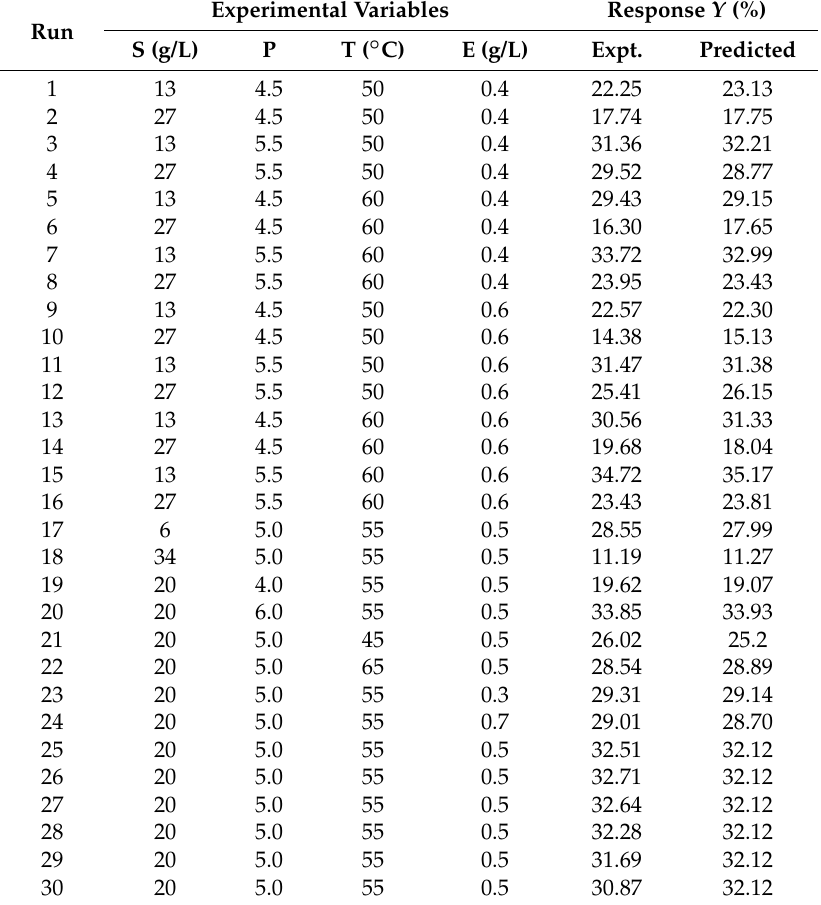
Table 3. Central composite design matrix and its response and predicted